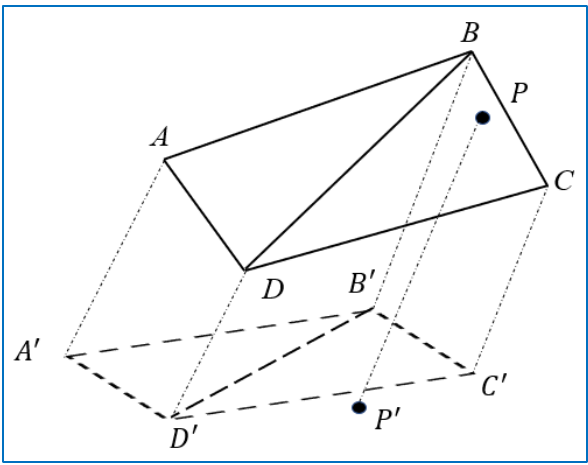
Figure 8. The principle of projection point inclusion detection.